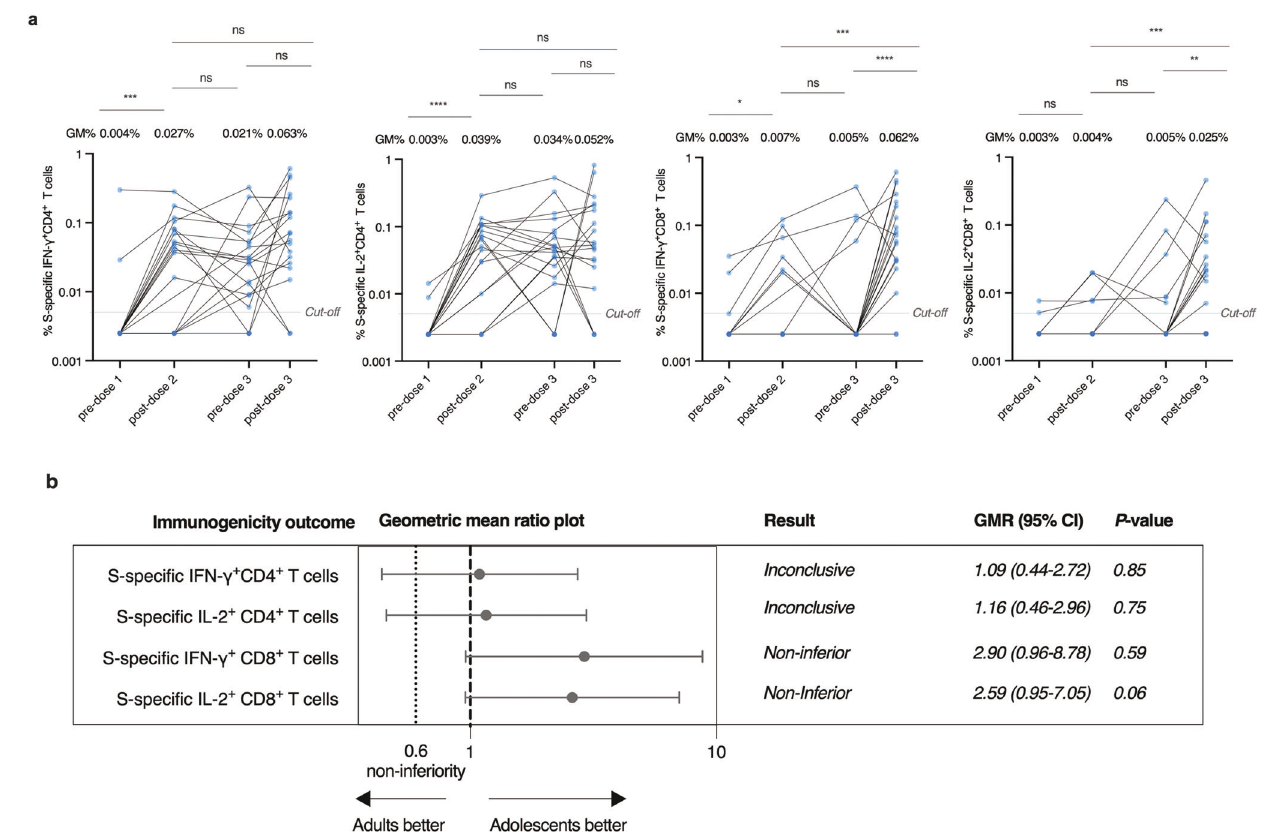
Fig. 2 Adolescents have boosted CD8 + T cell responses to the WT virus after the third dose of the BNT162b2 vaccine. a Longitudinal analysis of S-speci fi c interferon- γ (IFN- γ ) + CD4 + , interleukin-2 (IL-2) + CD4 + , IFN- γ + CD8 + , and IL-2 + CD8 + T cells responses in evaluable adolescents (pre-dose 1 N = 18, post-dose 2 N = 18, pre-dose 3 N = 21, post-dose 3 N = 19). A third dose booster increased the S-speci fi c IFN- γ + CD8 + and IL-2 + CD8 + T cell responses, while IL-2 + CD8 + T cell responses were higher post-dose 3 compared to post-dose 2. Longitudinal analysis was determined using paired t -test after natural logarithmic transformation with p values denoted. Dots representing the same participants are linked by a straight line. Data labels and centre lines show geometric means (GM) estimates, with corresponding 95% con fi dence intervals shown by error bars. b Non-inferiority test of S-speci fi c IFN- γ + CD4 + (adolescent N = 26, adult N = 28), IL-2 + CD4 + (adolescent N = 26, adult N = 28), IFN- γ + CD8 + (adolescent N = 26, adult N = 28) and IL-2 + CD8 + (adolescent N = 26, adult N = 28) T cell responses in evaluable adolescents in comparison to adults. Geometric mean ratios (GMR) and two-tailed 95% con fi dence intervals (CI) were plotted. S-speci fi c IFN- γ + CD8 + and S-speci fi c IL-2 + CD8 + T cell responses were non-inferior, while S-speci fi c IFN- γ + CD4 + and S-speci fi c IL-2 + CD4 + T cell responses were non-conclusive. Geometric mean ratios and their associated two-sided 95% con fi dence intervals (CIs) were plotted. * p < 0.05, ** p < 0.01, *** p < 0.001, **** p < 0.0001. ns not signi fi cant. Cut-offs were drawn as grey lines. WT